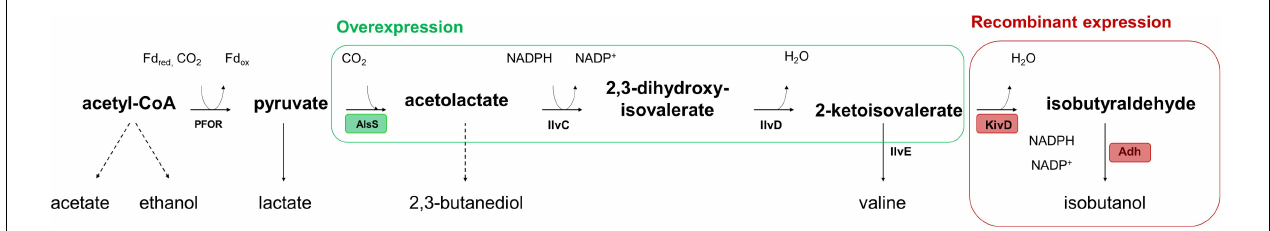
FIGURE 5 | Recombinant isobutanol pathway in CLJU[KAIA] characterized by plasmid-encoded amplification of pyruvate-to-KIV conversion followed by the conversion of KIV via recombinant Ehrlich pathway. PFOR: pyruvate:ferredoxin-oxidoreductase; AlsS: acetolactate synthase; IlvC: ketol-acid reductoisomerase, IlvD: